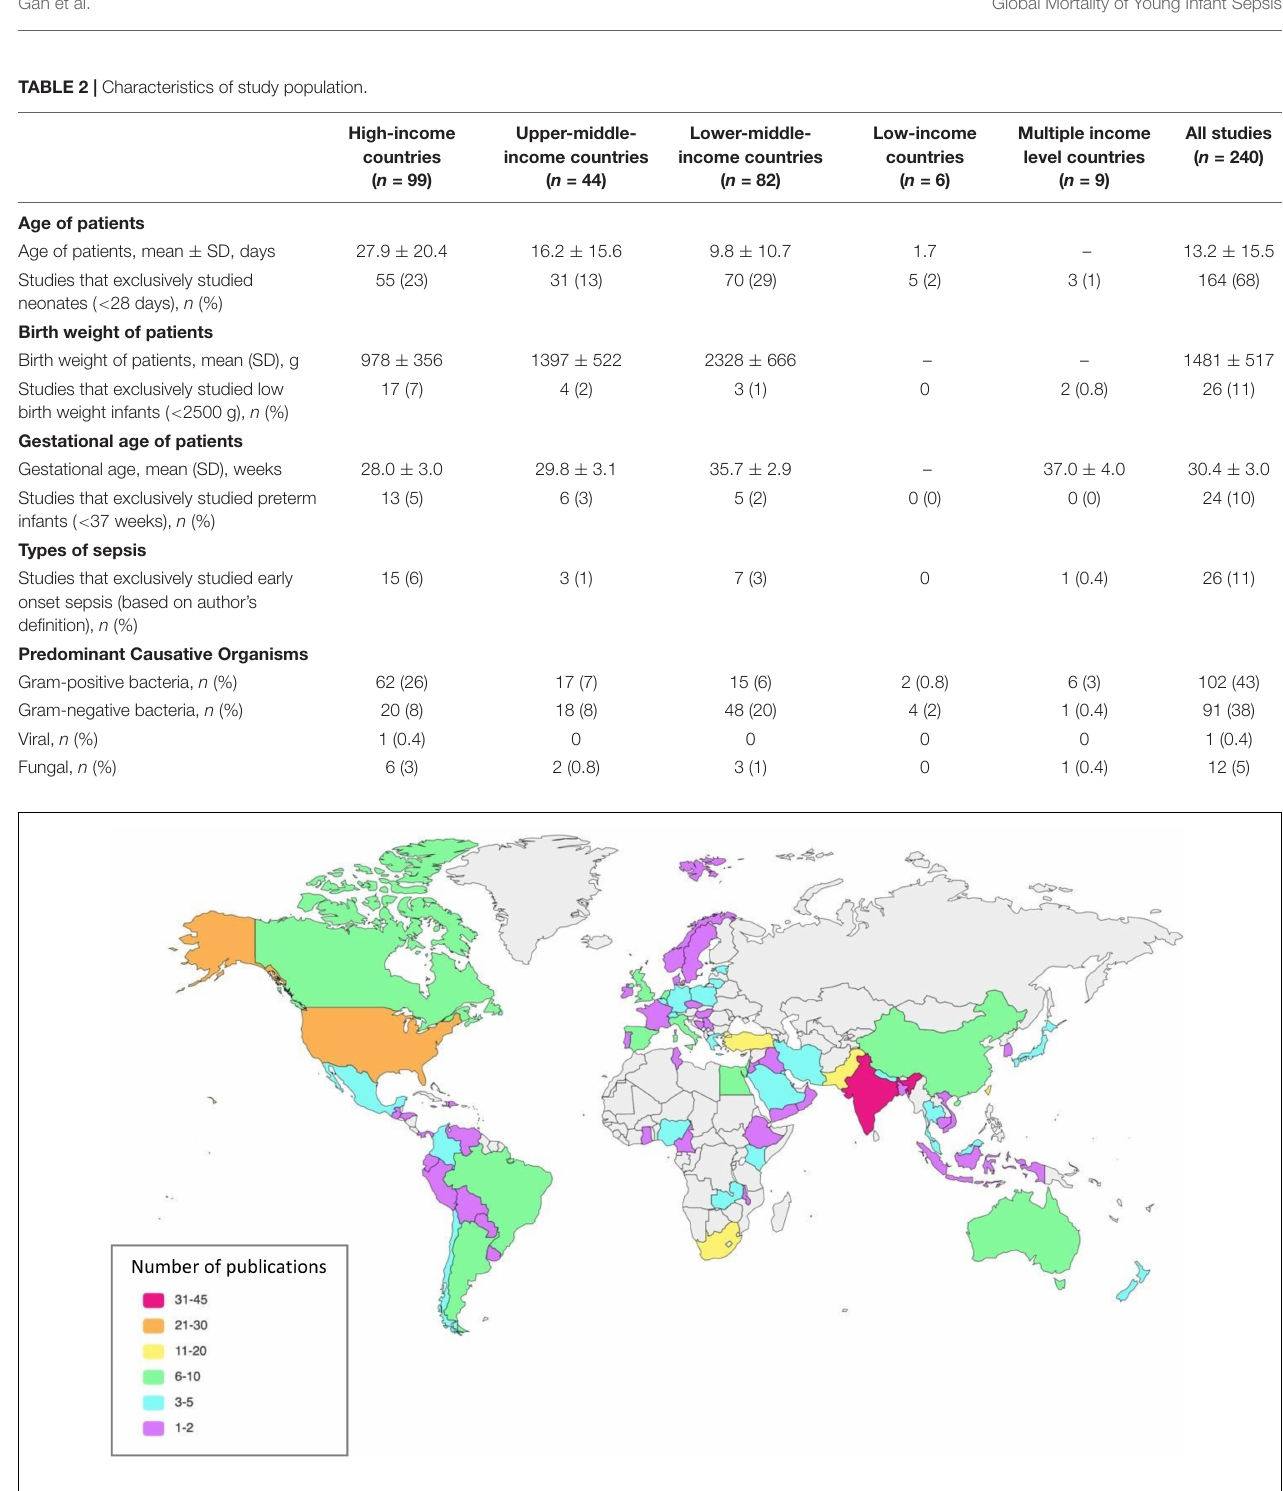
FIGURE 2 | Publication by